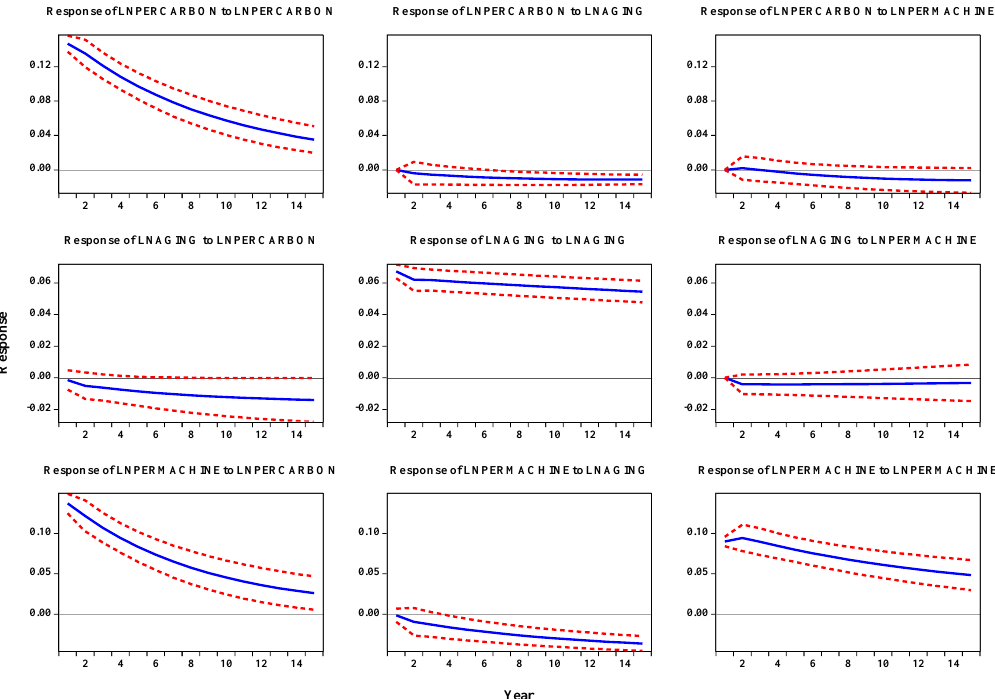
Figure 3. Impulse response diagram of three variables. Note: The horizontal axis represents time, and the vertical axis reflects the impact. The solid blue line in the middle represents the impulse response function, and the red dotted lines on both sides represent the upper and lower lines of the 95% confidence interval, respectively.